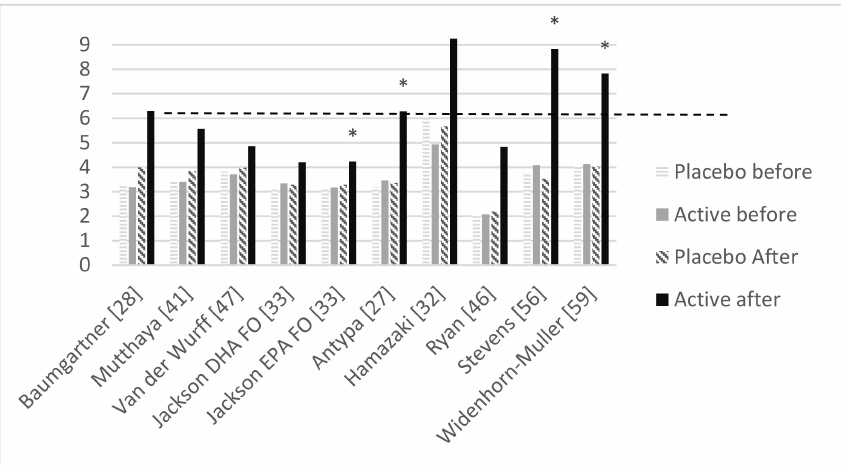
Figure 2. Omega-3 index equivalence at start and end of study for active and placebo group for studies in which blood was collected and recalculation to the Omega-3 index equivalence was possible. Studies in which a positive effect of supplementation was shown are indicated with an *. Note that Jackson et al. are in the figure twice as their study included an eicosapentaenoic acid (EPA) arm and a docosahexaenoic acid (DHA) arm. FO = fish